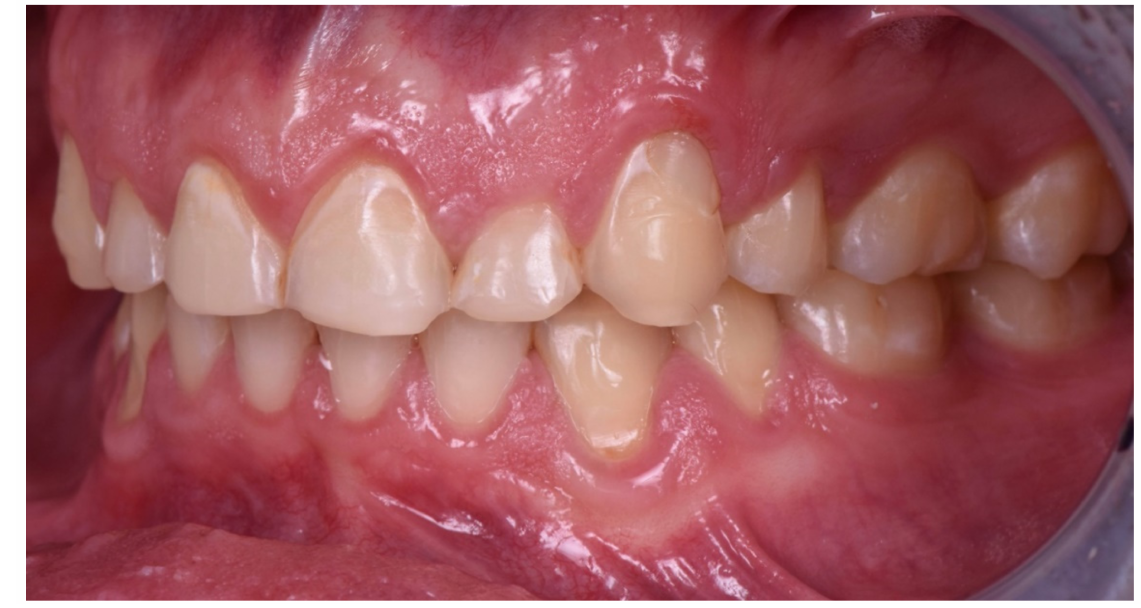
Figure 7. Intraoral picture (left).